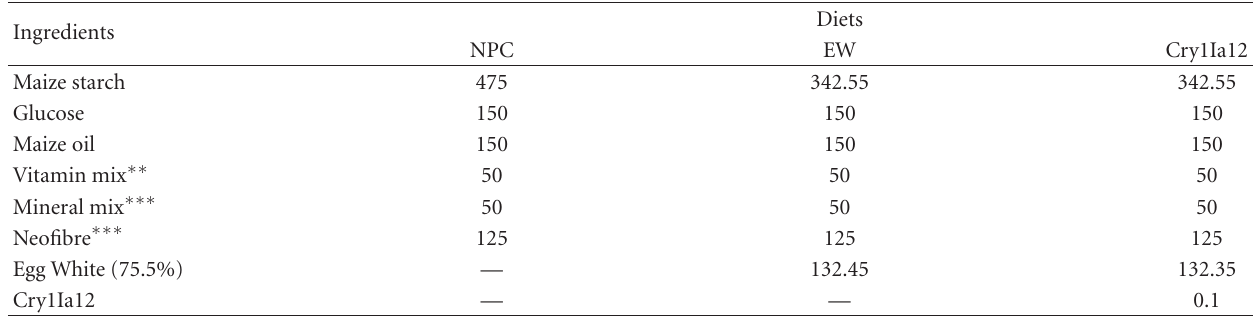
Table 1: Composition (g/kg) of the NPC, EW, and experimental diets ∗